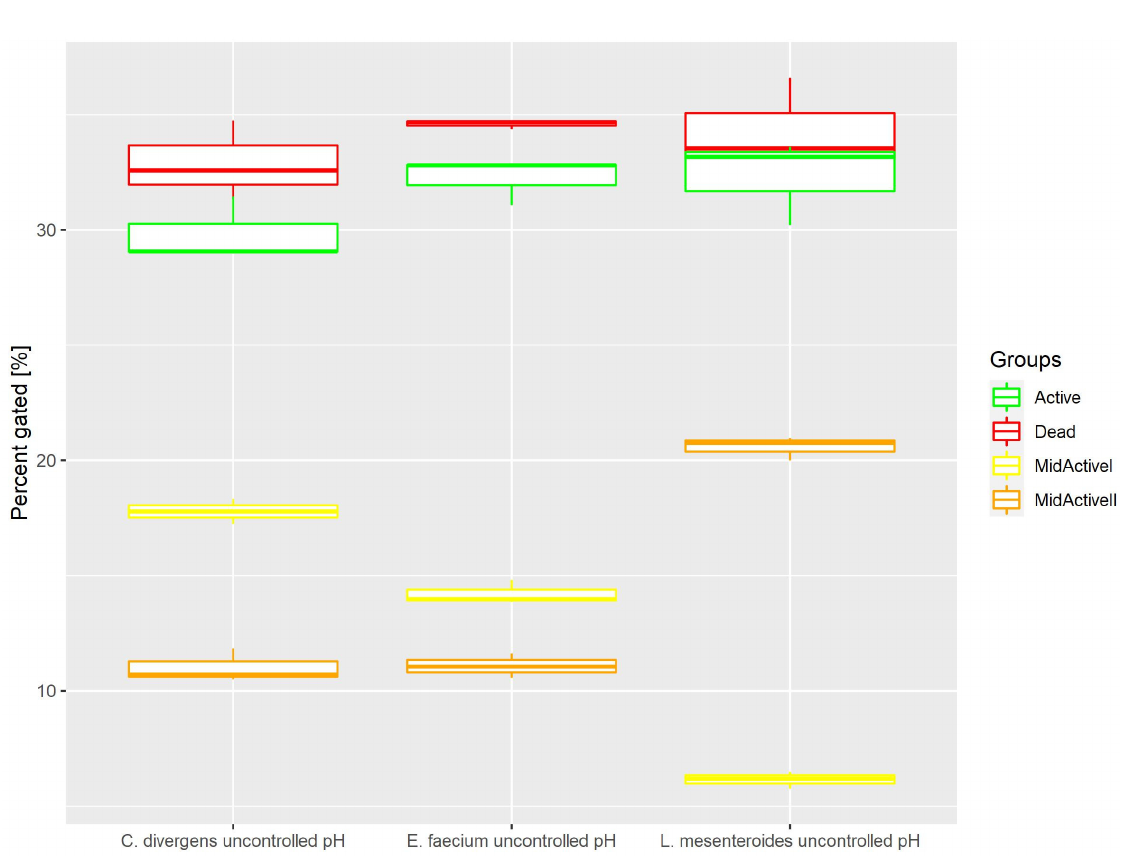
Figure 6. Cell subpopulation percentages in samples cultured without pH control. The distribution of cells between different groups was measured after culturing without pH regulation.